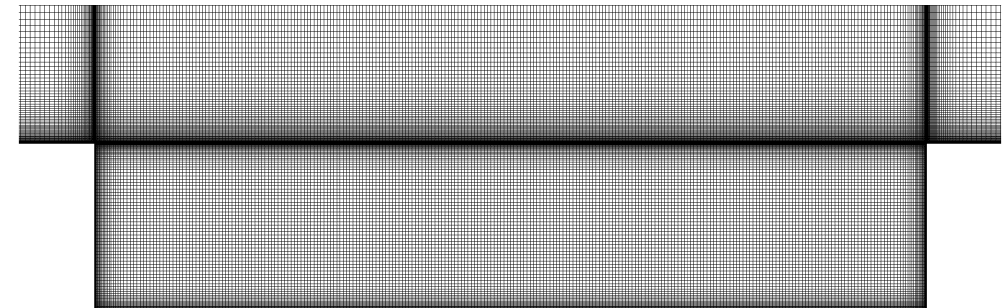
Figure 4. Cross-section of the grid for the wind tunnel model in the xz -plane at y = 0.